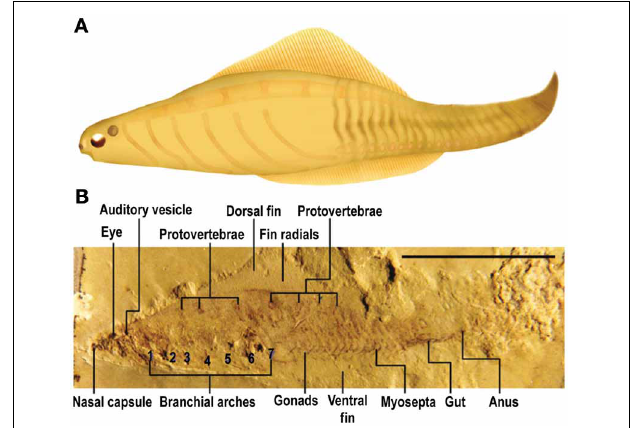
FIGURE 6 | Haikouichthys . (A) Artist’s rendering of what Haikouichthys looked like. (B) Fossil of this animal with an eye and otic capsule (“Auditory vesicle”) labeled. Haikouichthys is agreed to have been a true vertebrate, a jawless fish, and it shows vertebral elements (protovertebrae), prominent eyes, and nasal capsules (Shu, 2003; Shu et al., 2003, 2009). From Figure 146 in Chen (2012) Springer. Reprinted with kind permission from Springer Science + Business Media